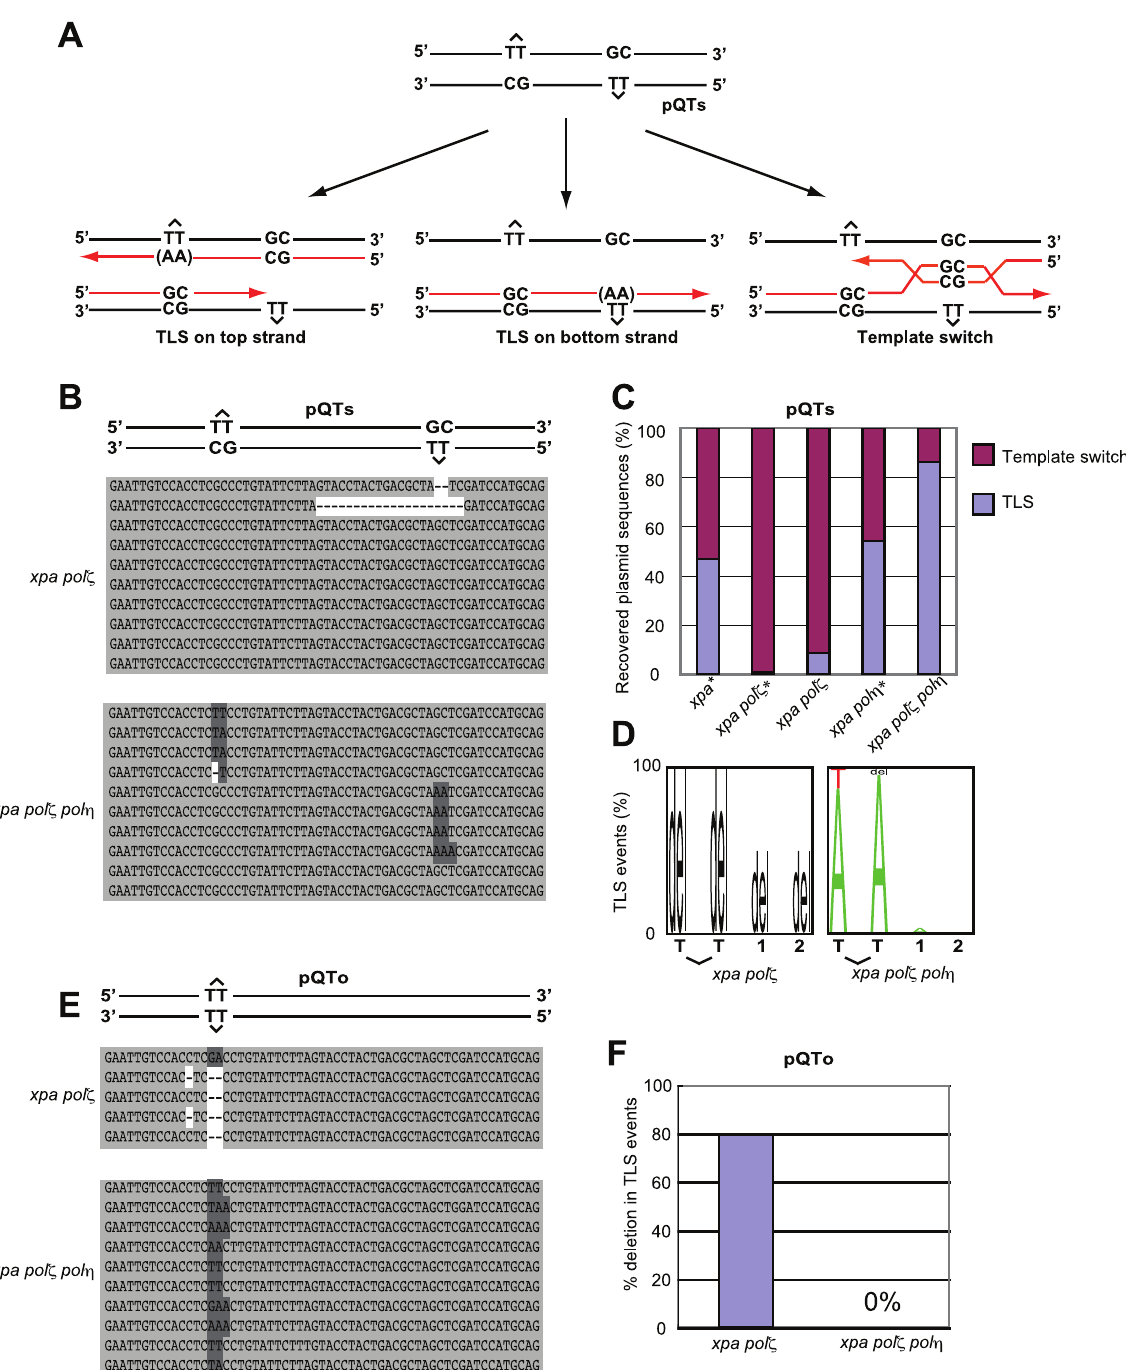
Figure 5. TLS past a T-T (6-4) UV photoproduct on episomal plasmid DNA. (A) Schematic of the staggered arrangement of T–T (6–4) UV photoproducts in the construct pQTs. The dinucleotide GC is placed opposite each lesion, and there are 28 bp between the lesions, with the possible outcomes of DNA replication over the area. TLS may occur on either the top or the bottom strand, with the most common base insertion shown as AA. Alternatively, the nascent strand of the sister chromatid may be used as an alternative undamaged template; one possible mechanism for such a template switching illustrated. (B) Example sequences of replicated pQTs plasmids recovered from xpa/pol f and xpa/pol g /pol f clones, aligned with a schematic drawing of pQTs. TLS on the top strand (inserting mostly AA in the reverse direction, top set), TLS on the bottom strand (middle set), and error-free bypass (bottom set) are shown. Proportions are not representative. (C) The proportion of TLS versus error-free bypass in pQTs sequences recovered from xpa/pol f and xpa/pol g /pol f cells, shown as a percentage of the total. Data shown with asterisks are taken from Szu¨ts et al. [28]. A total of 23 and 29 sequences from xpa/pol f and xpa/pol g /pol f cells, respectively, are shown as the sum of three independent experiments. (D) The pattern of nucleotide incorporation opposite the T-T (6-4) photoproduct in xpa/pol f and xpa/pol g /pol f cells. Error-free pQTs sequences were excluded from analysis. The percentage of each nucleotide incorporated at each position is indicated by the size of the letter of the nucleotide in the column. del=deletion. The incorporation positions indicated are at the 3 9 T and the 5 9 T of the lesion, followed by the next two bases in the template,